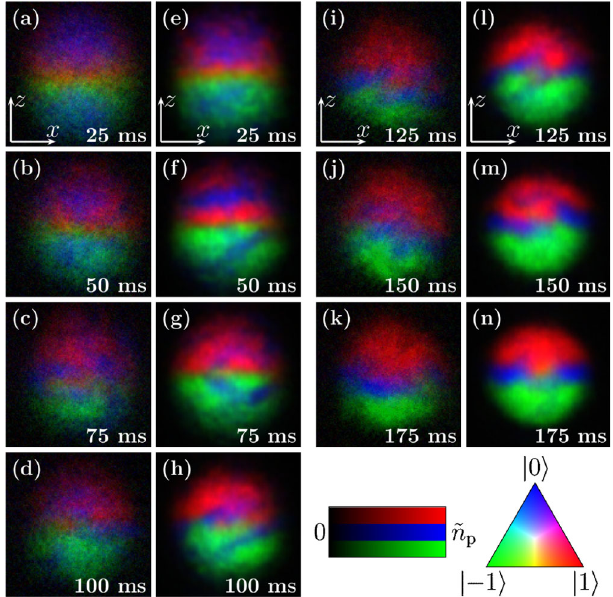
FIG. 3. Column particle densities imaged along y in the three − z -quantized spin states during the decay of an isolated monopole for (a – d,i – k) experiments and (e – h,l – n) simulations. The hold times are indicated in the bottom-right corner of each 4 . 3 G = cm. The peak panel. The quadrupole field gradient is b q ¼ 8 . 5 × 10 8 cm − 2 , and the field of view in particle density is ~ n p ¼ each panel is 228 × 228 μ m 2